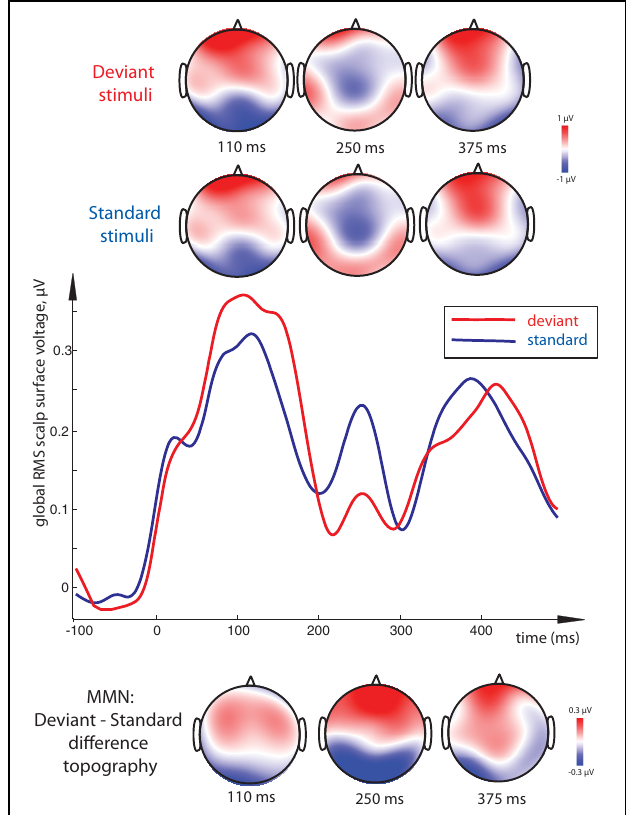
FIGURE 4 | Visual Mismatch Negativity effect: global RMS of standard and deviant responses to word and pseudoword stimuli (middle), and surface topography of standard and deviant responses (top) and of their difference (vMMN, bottom). Standard-deviant contrast (vMMN) was most significant at 100–120ms and 240–260ms peak intervals, and is seen as a bipolar distribution with posterior negativity and frontal positivity. As the standard-deviant contrast did not interact with lexicality and the vMMN did not distinguish between conditions, data from both word and pseudoword conditions are pooled together for this display. Timecourse of activity elicited by the orthographic stimuli shown here has been subtracted by that in the sensory baseline control